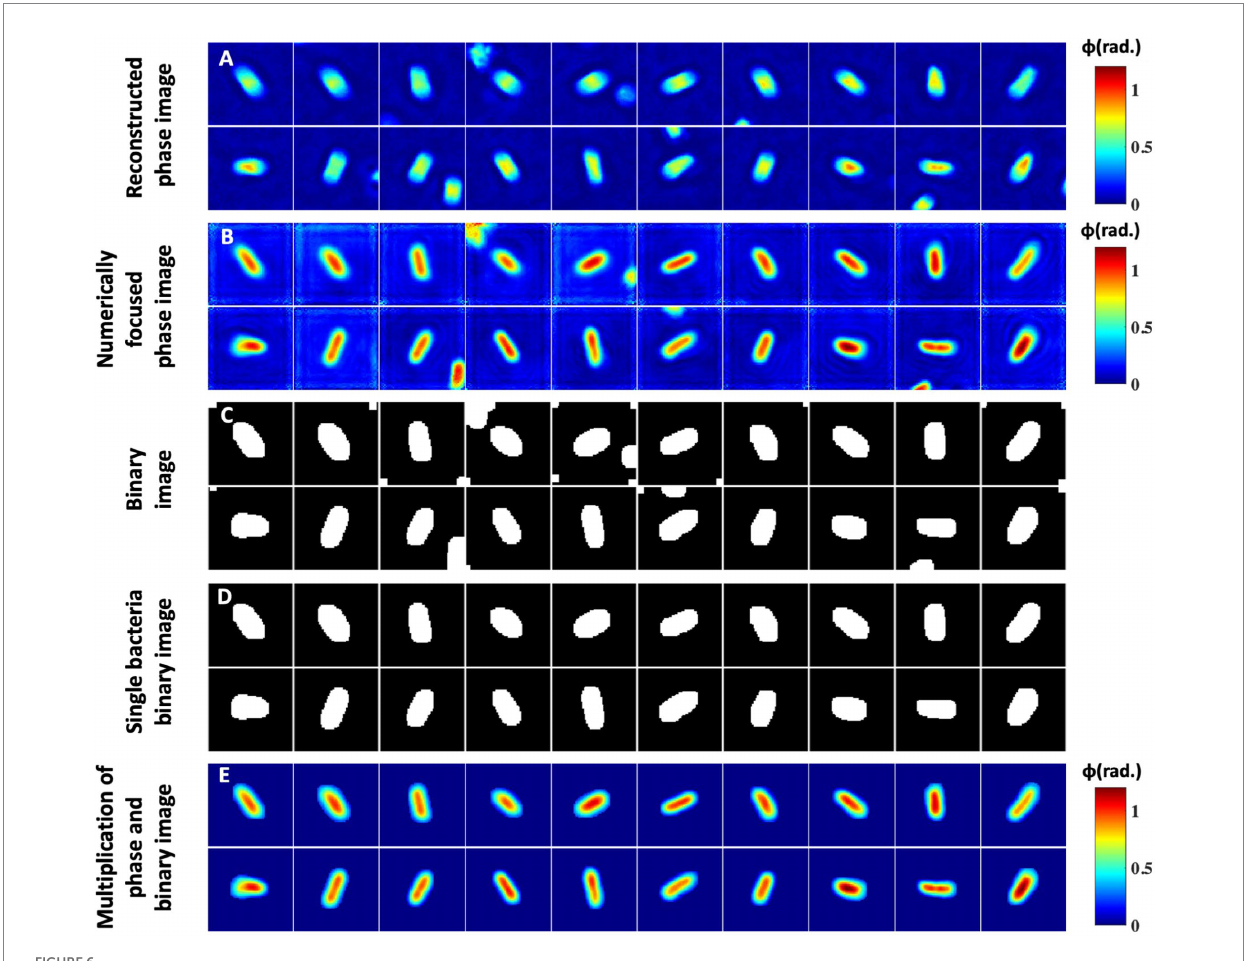
FIGURE 6 Segmentation and postprocessing pipeline for individual bacteria images. (A) Reconstructed phase maps of the individual bacteria cells. (B,C) Numerically focused phase images and corresponding binary maps. Some phase images have multiple bacteria at the edges, which need to be removed. (D) Represents a single bacteria binary mask. (E) Multiplication of the numerically focused phase maps and single bacteria binary